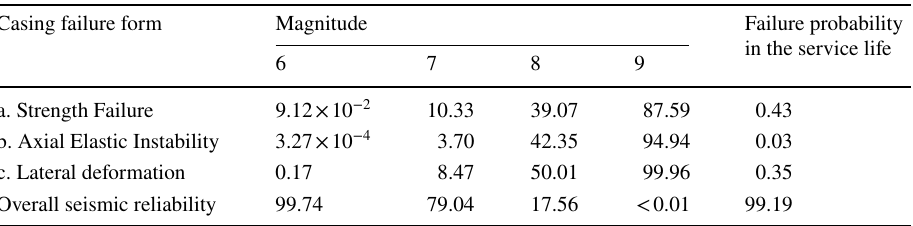
Table 5 Casing string failure probability in earthquakes of different magnitudes during service life